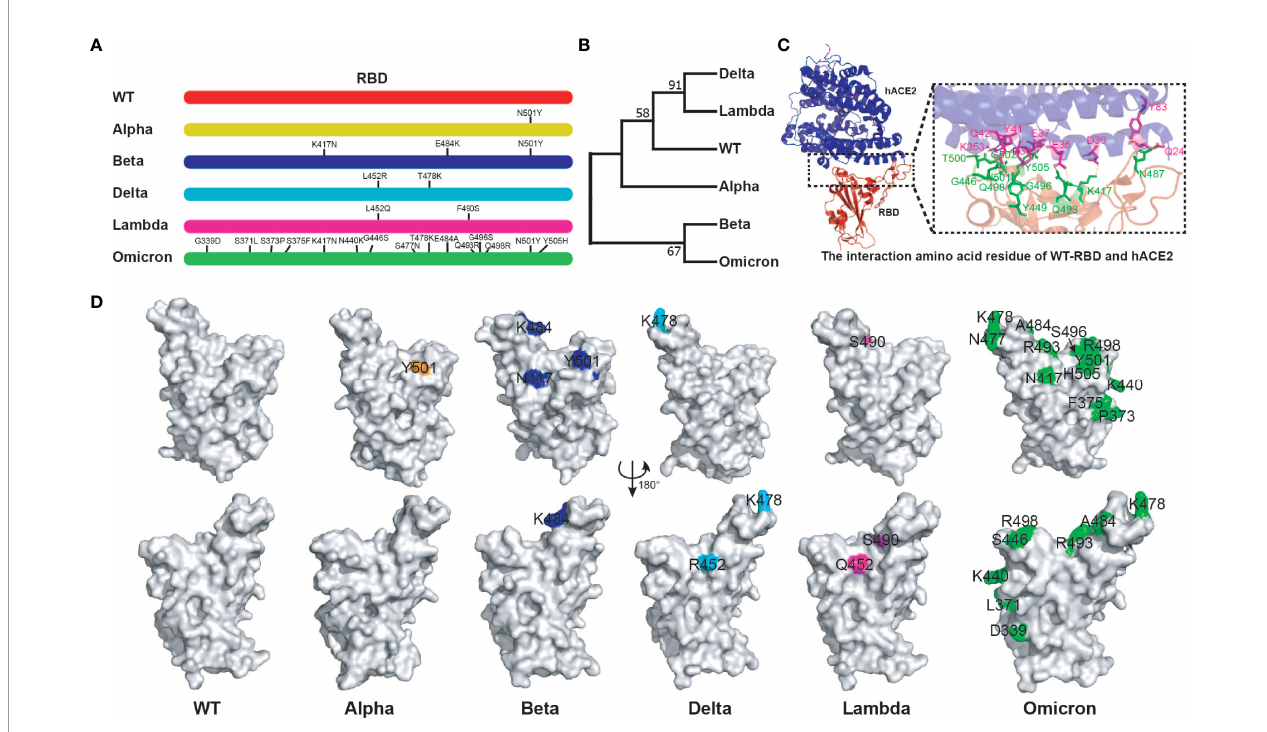
FIGURE 1 | Bioinformatics analysis of SARS-CoV-2 variant RBD. (A) The mutation sites of different variant RBDs. (B) The evolutionary trees of different variant RBDs. The phylogenetic tree was constructed using the maximum likelihood method within MEGA software (version 11.0). (C) The interaction amino acid residues of WT RBD with hACE2 (PDB:6MOJ). Green: RBD amino acid residue; Purple: hACE2 amino acid residue. The image was rendered in PyMOL (version 4.60). (D) The distribution of mutant amino acids on RBD structures of different variants. Source of protein crystal structure data from PDB database: WT (6MOJ), Alpha (7EDF), Beta (7PS4), Delta (7WBQ), and Omicron (7WBP). The crystal structure of Lambda RBD was constructed using Swiss-Model online tools. The image was rendered in PyMOL (version